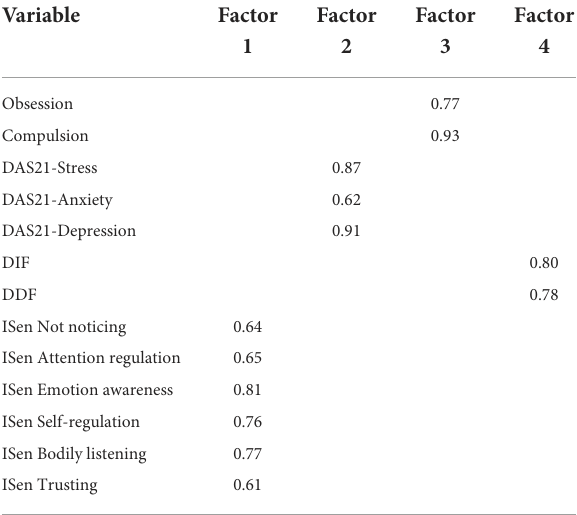
TABLE 8 Pattern matrix of four groups as identified through